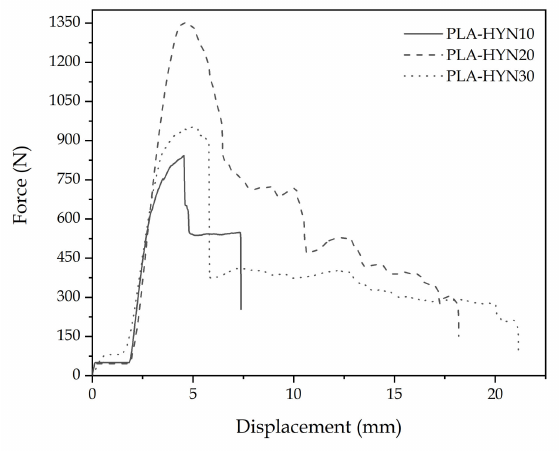
Figure 2. Characteristic force–displacement diagrams (three-point bending) for composite sand- wiches with PLA honeycomb cores with different